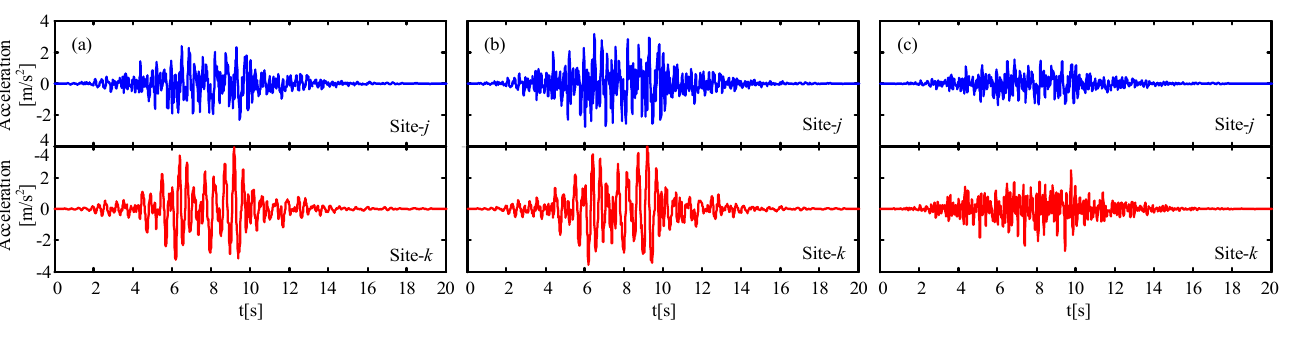
Figure 3. Simulated ground motions for: ( a ) horizontal out-of-plane motion; ( b ) horizontal in-plane motion; and ( c ) vertical in-plane motion Cs SI = 100 m/s, D SI = 5 m, and H SI = 5 m.